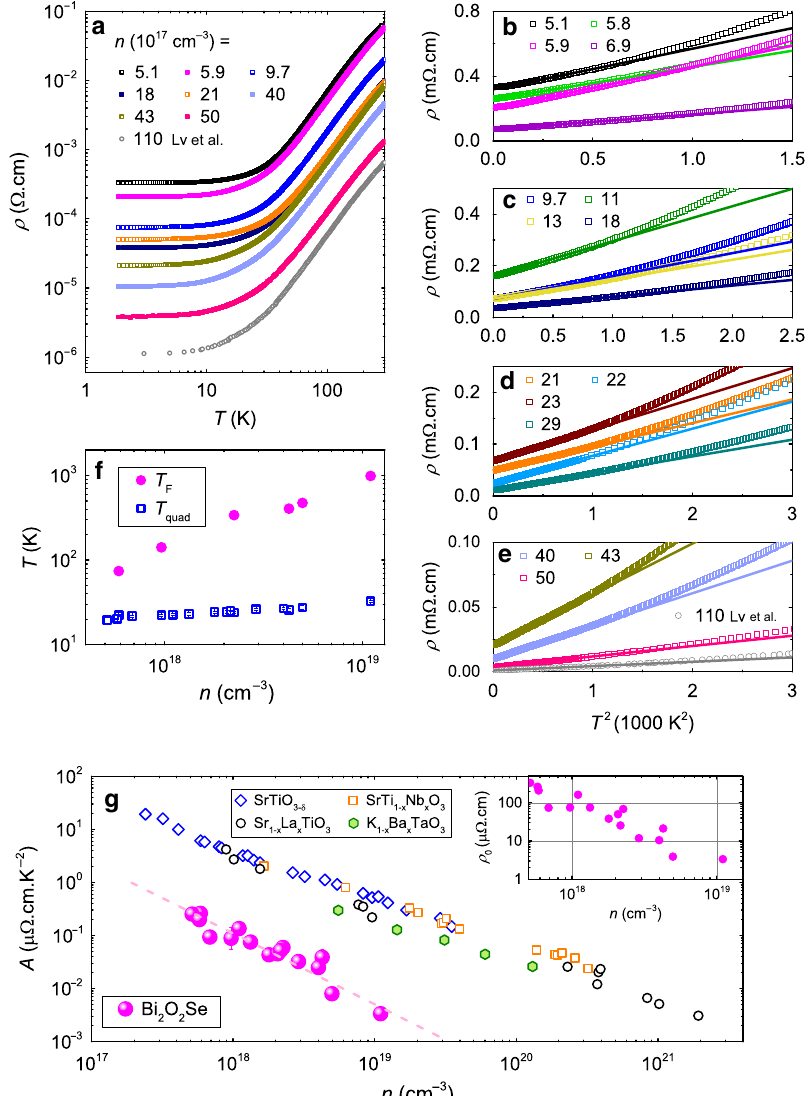
Fig. 2 Temperature-dependent resistivity of Bi 2 O 2 Se at various Hall carrier concentrations ( n ). a Resistivity as a function of temperature from 1.8 – 300K on a Log – Log scale. The data at n ≈ 1.1 × 10 19 cm − 3 are from ref. 22 . b – e The low- T resistivity as a function of quadratic temperature. The linear lines are fi ts by Eq. (1). f T F and T quad as a function of n . T quad is a characteristic temperature above which the resistivity deviates from the T 2 behavior. T F and T quad are represented by solid magenta circles and open blue squares respectively. The error bars denote uncertainty in determining T quad from b – e . g The slope of T 2 resistivity ( A ) as a function of n for Bi 7 : open blue diamonds, SrTi 7,11 : 2 O 2 Se: solid magenta circles, compared with doped SrTiO 3 (SrTiO 3 − δ 1 − x Nb x TiO 3 open orange squares, and Sr 1 − x La x TiO 3 10 : open black circles) and K 1 − x Ba x TaO x 45 : solid olive hexagons. The dashed line is a guide to eyes. The inset shows the variation of residual resistivity with increasing n for Bi 2 O 2